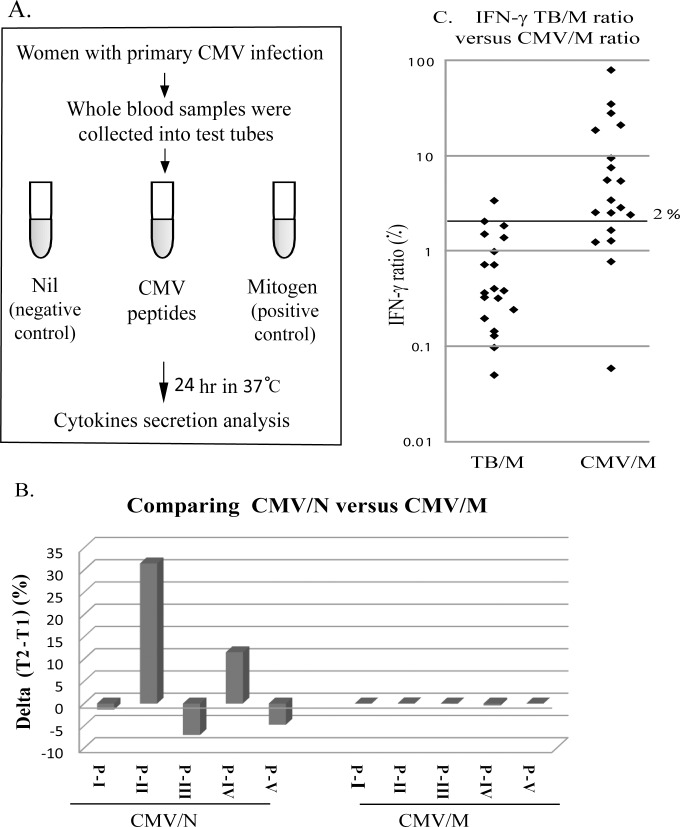
Normalization method of individual IFN-γ specific response.A. Schematic representation of the in-vitro stimulation assay. Blood samples of 76 pregnant women with primary CMV were stimulated with either CMV peptides or PHA, for 24 hours at 37°C. The amounts of IFN-γ, TNF-α, IL-10 and IL-6 in the supernatant were determined by CBA analysis. B. Comparing normalizations of IFN-γ induced after CMV stimulation to Nil or Mitogen tubes. We compared the ratios between the levels of IFN-γ induced by CMV peptides divided by that of 'nil' (CMV/N) or 'Mitogen' (CMV/M). Blood samples of five patients (P-I to P-V) were taken in two different time points, T1 and T2 (intervals of 5–8 weeks). Delta determined as the ratio at T1 subtracted from the ratio at T2. C. Comparing IFN-γ TB/M to IFN-g CMV/M ratio. Blood samples of 19 women were collected into Nil, CMV and mitogen tubes, and an additional tube containing Mycobacterium tuberculosis (TB) antigens. We compared the IFN-γ induced by CMV peptides to the IFN-γ induced by TB peptides both normalized to the amount of IFN-γ in the Mitogen tube.